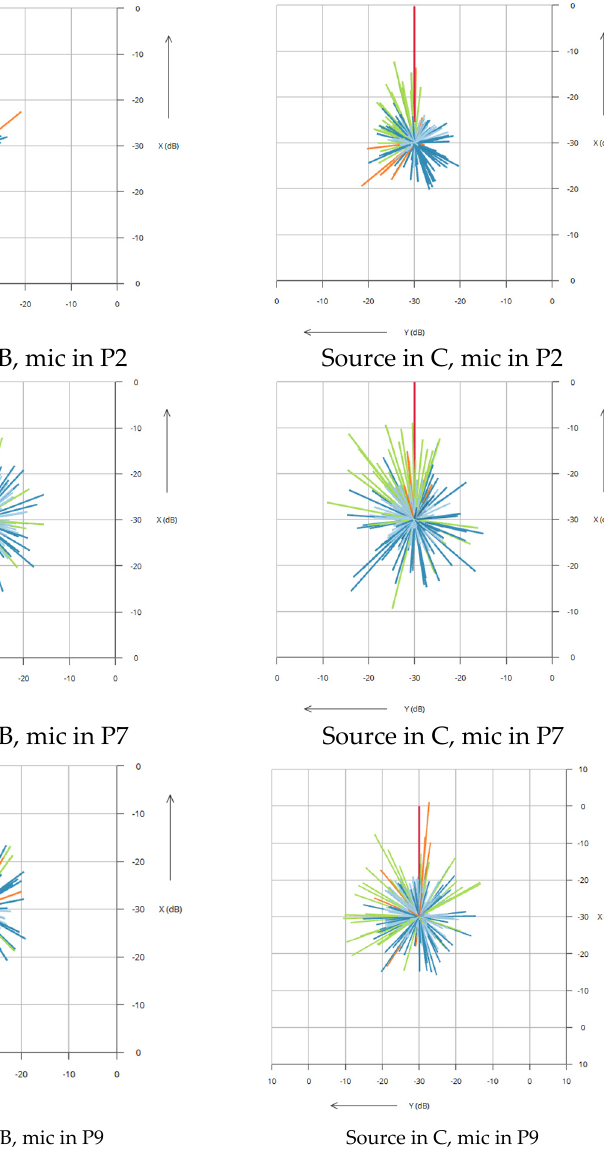
Figure 11. Directions of arrival of reflections. 30 dB range.